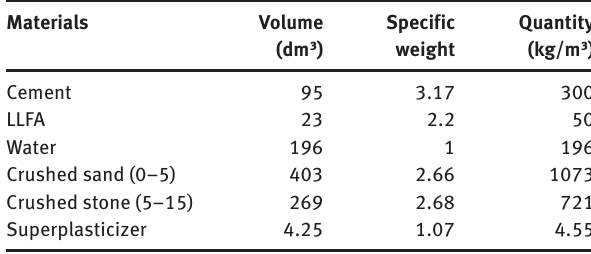
Table 2: Materials mixed in 1 m 3